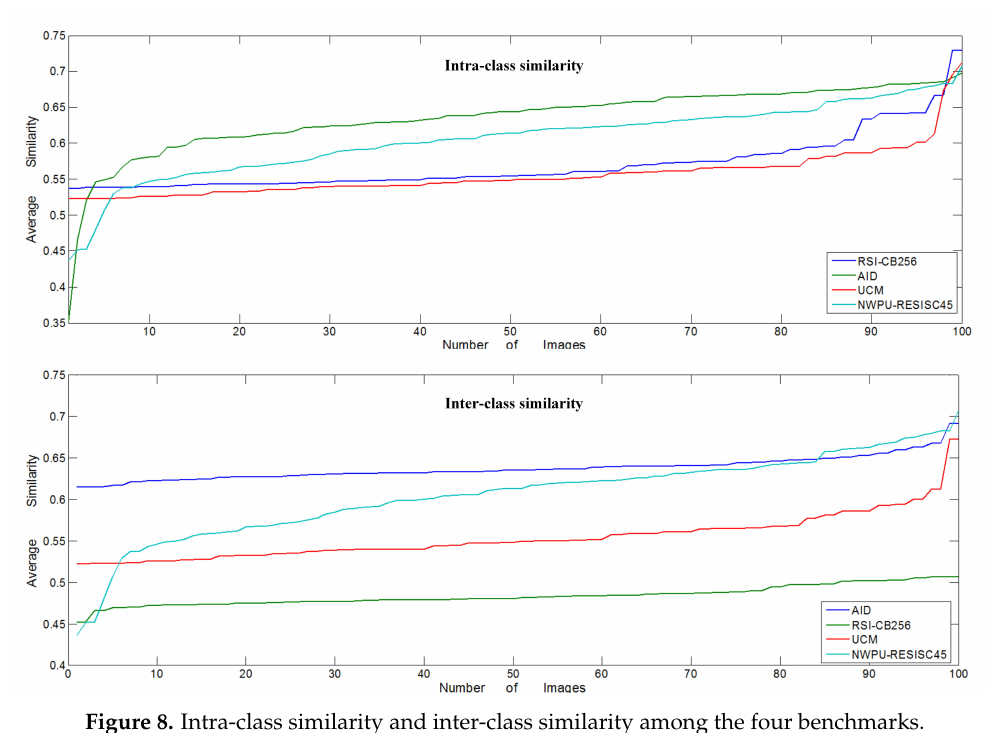
Figure 8. Intra-class similarity and inter-class similarity among the four benchmarks.